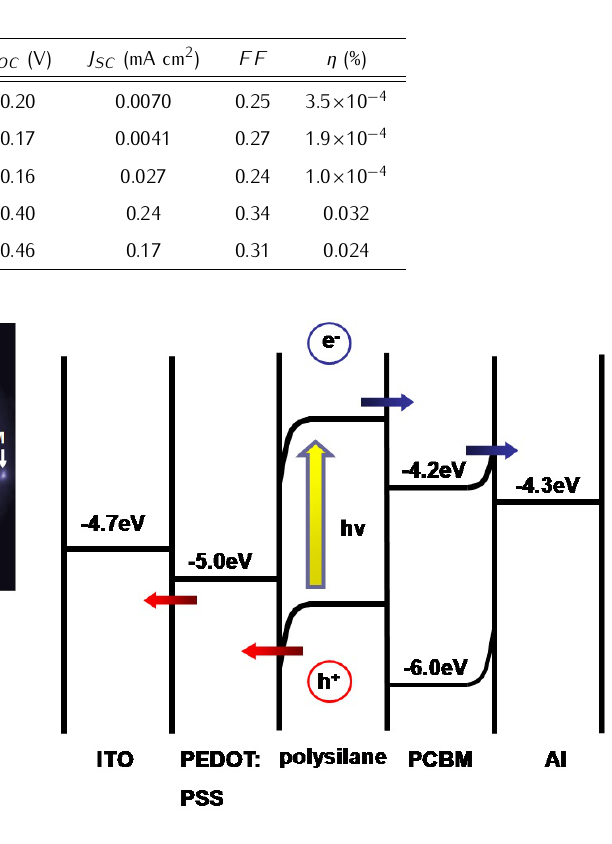
Figure 7. Energy level diagram of polysilane:PCBM solar cells